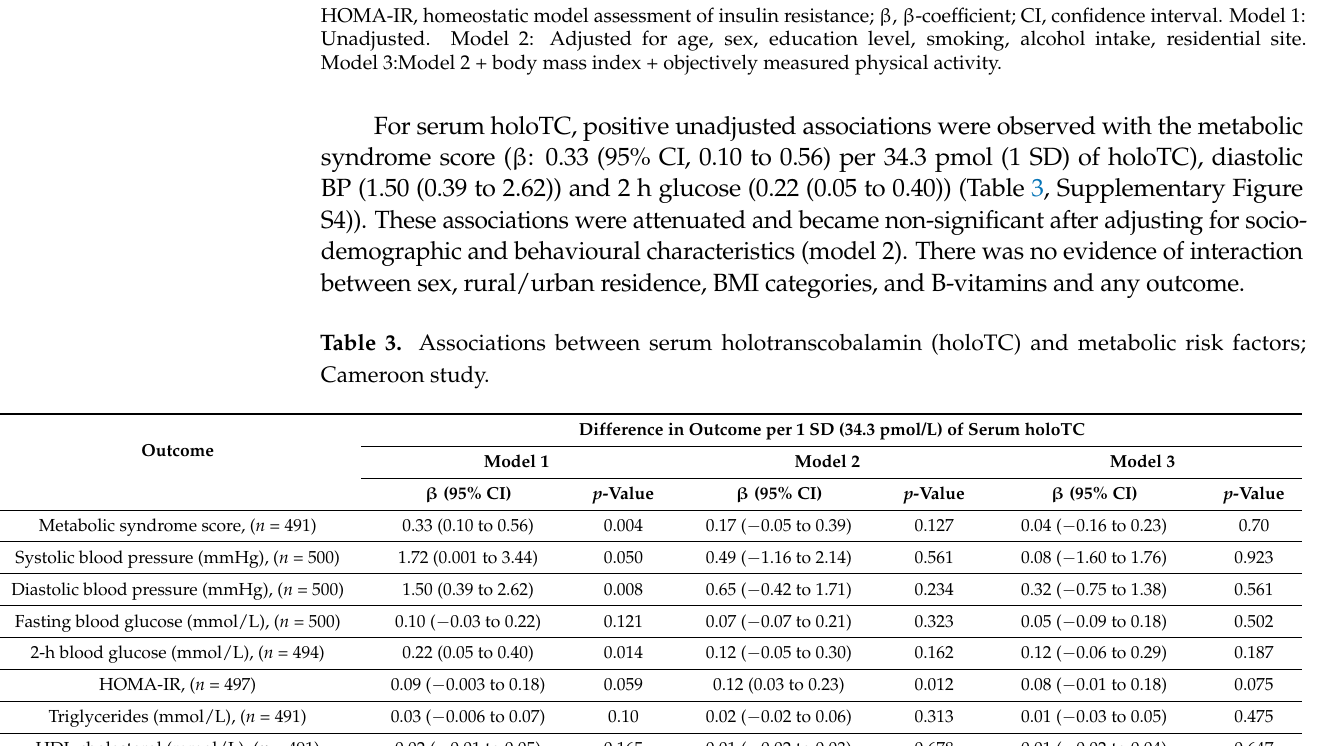
Model 3:Model 2 + body mass index + objectively measured physical activity.